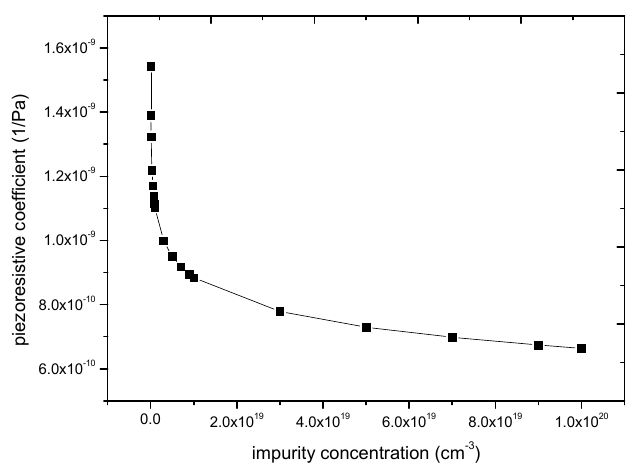
Figure 3. N-type piezoresistive coefficient ( π 11 − π 12 ) of different impurity concentrations.